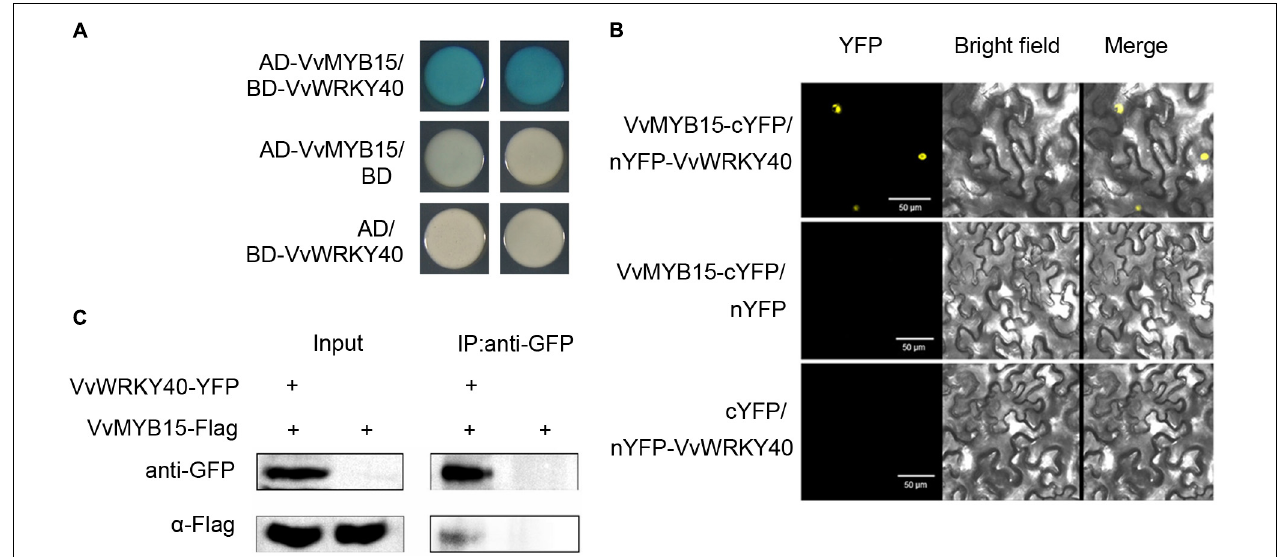
FIGURE 6 | Interaction of VvMYB15 with VvWRKY40 in yeast cell and plant cell. (A) Yeast two hybrid showing the interaction between VvMYB15 and VvWRKY40. (B) Bimolecular fluorescence complementation assay showing the interaction between VvMYB15 and VvWRKY40 in tobacco cells. Bars = 50 µ m. The images show overlays of fluorescence and light views. (C) Co-IP assay showing VvMYB15 and VvWRKY40 can interact in tobacco cell. VvMYB15-Flag and VvWRKY40-YFP or VvMYB15-Flag were co-expressed in tobacco